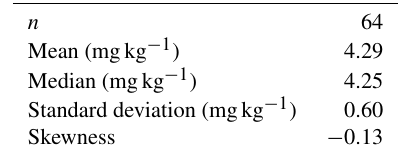
Table 1. Summary statistics on soil uranium content.